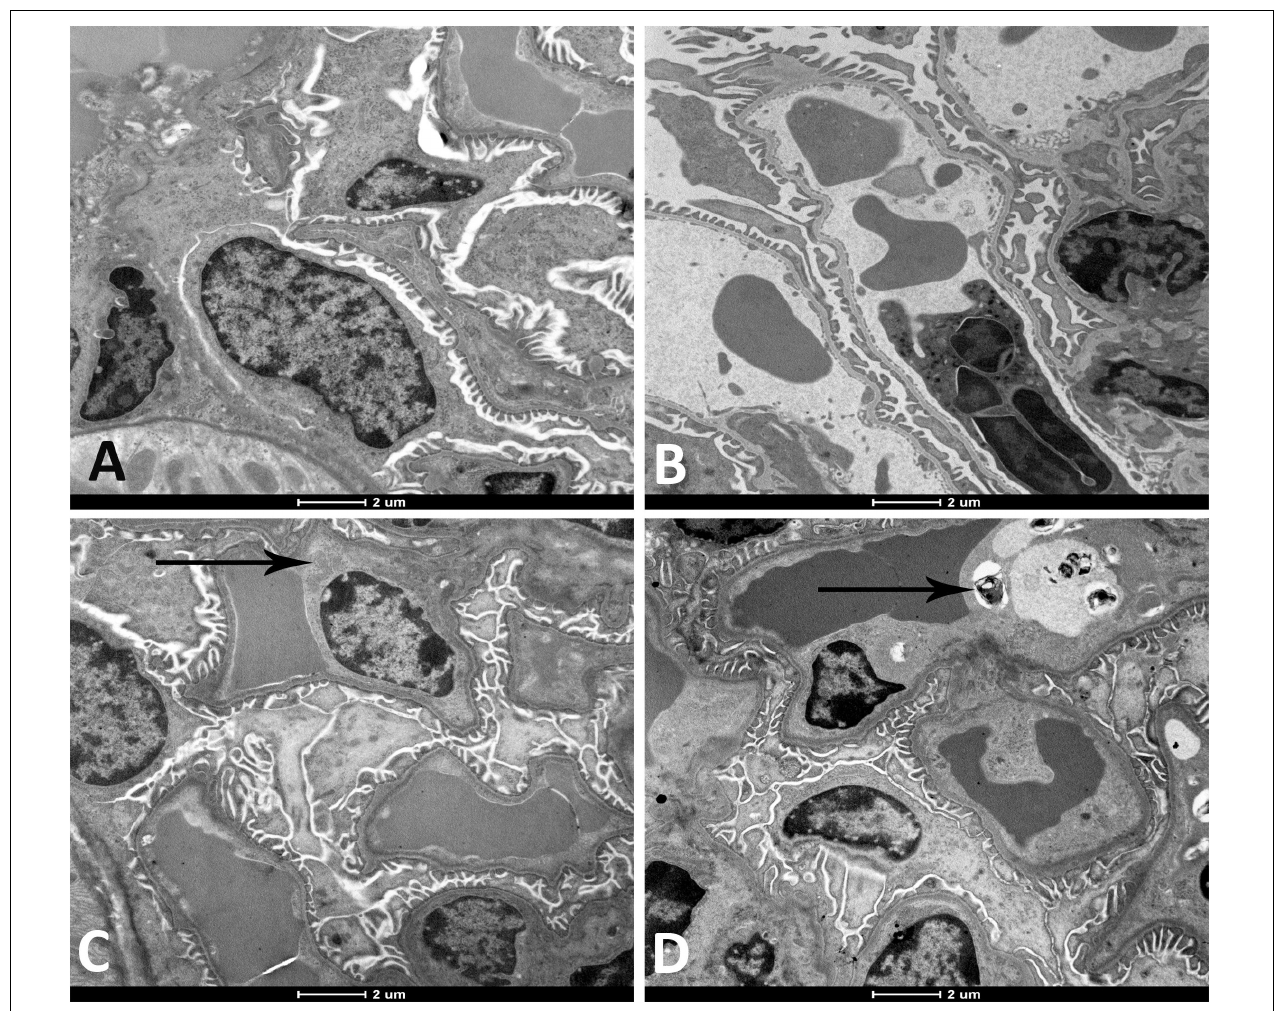
FIGURE 2 | Representative electron micrographs of the glomerular structures of the kidney of mice at the end of 1-week exposure period to air (control, A ), 1-week exposure period water pipe smoke (WPS) exposure (B) , 4-week exposure period to air (control, C ) or 4-week exposure period to WPS (D) . Degenerating endothelial cells (black arrow shown in micrograph D ) was discerned in the kidney of mice exposed to WPS at 4-week exposure period. Scale bar = 2 µ m; n =